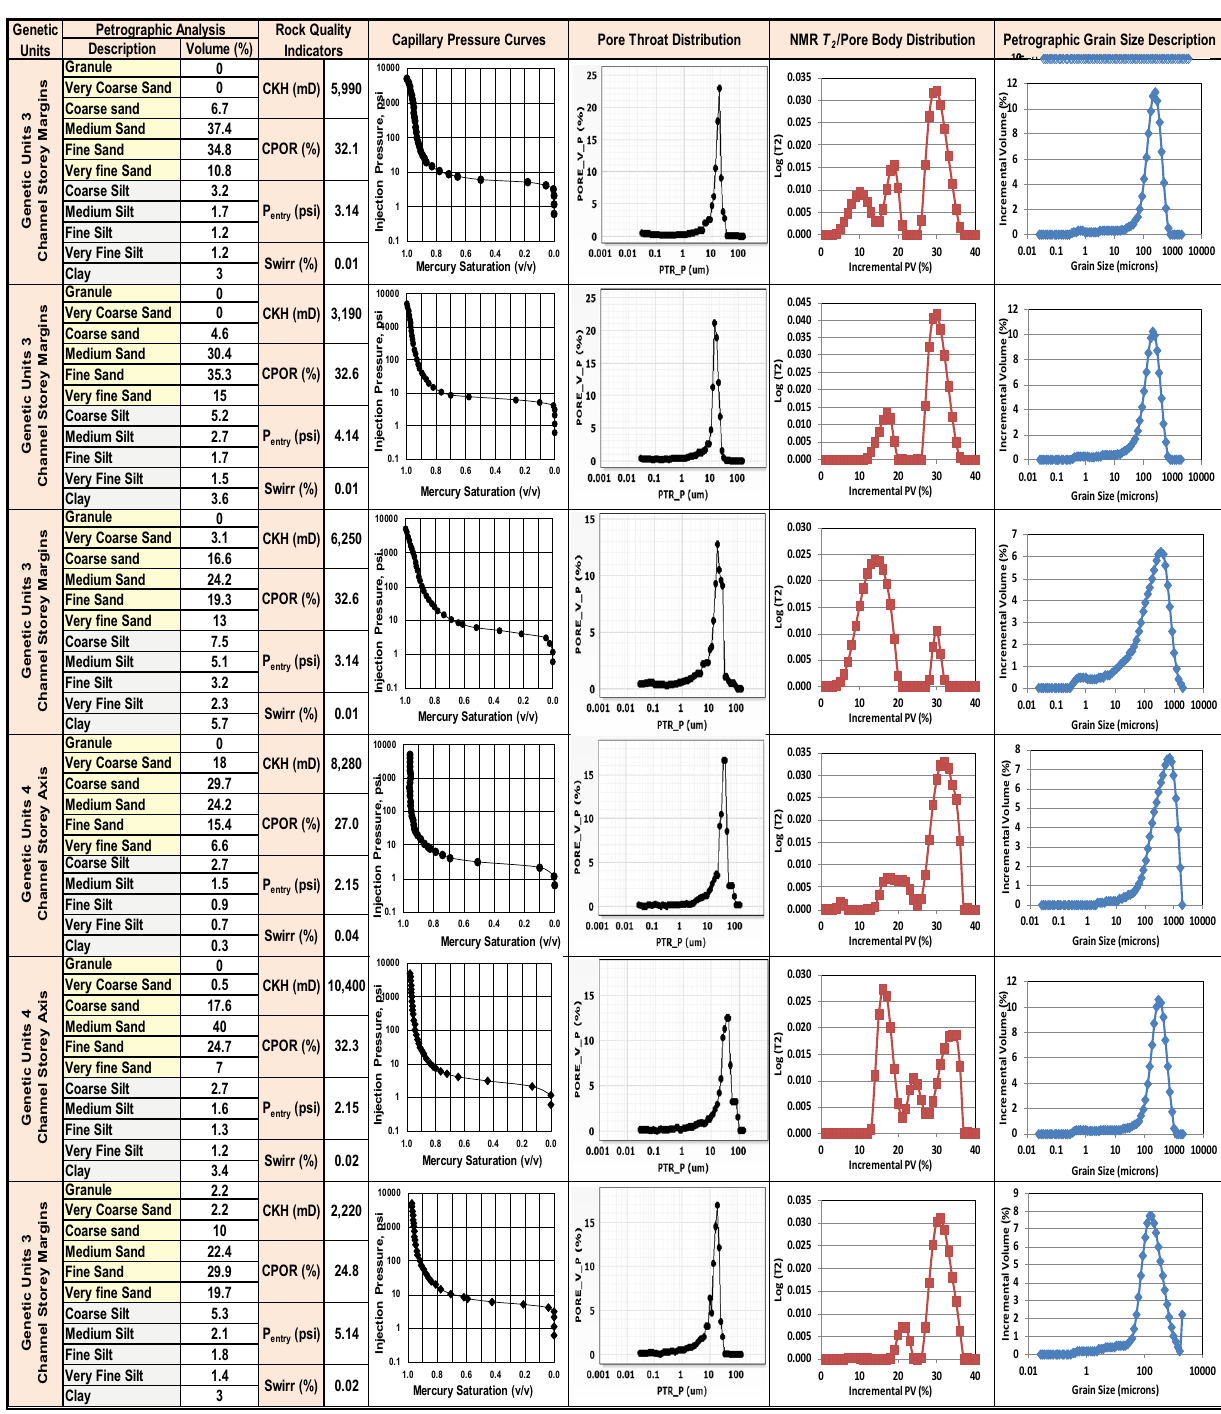
Fig. 12 Sample 6–11 employed for the study. This present petro- graphic grain analysis, NMR T 2 distribution and MICP distribution demonstrating various rock quality indicators; relationship between